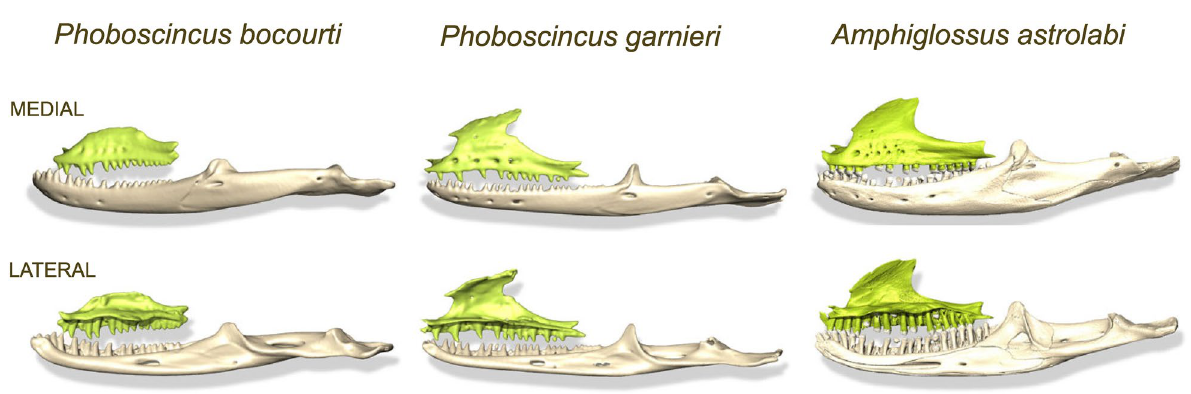
Figure 2. Figure showing different top mandible (in green) and bottom mandible (in white) for Phoboscincus bocourti, P. garnieri and Amphiglossus astrolabi (Beamline An extraordinary example of a rediscovered species is Bocourt´s Terrific Skink Phoboscincus bocourti (Broc- chi, 1876). It was only known from its holotype (supplementary Fig. S1), captured around 1870 in New Caledonia with no further precise locality data, but most likely captured on the largest island called Grande Terre 7 . In 2000, a juvenile was found dead, but not collected, on the beach on an islet off Île des Pins. It was likely prey dropped by a raptor. The first live and immediately correctly identified specimen was found in 2003 by one of us (II) and released. Subsequently one individual was captured and released in 2005, (II), seven other specimens (three captured and released and four more were photographed) in 2012 (by, MH and II), and another individual, illegally collected, in 2018 8 . Of the nearly 100 lizards endemic to New Caledonia and the 19 species native to the Île des Pins (Isle of Pins) (152 km 2 ) 9 , only P. bocourti is restricted to one satellite islet of the Isle of Pins (less than 1 km 2 area). Although this species is most likely present in several other surrounding islets 10 , it is one of the most geographically restricted endemic skink species in the world (Fig. 1). The unusual large size of the holotype [50 cm total length, 28 cm snout-vent length (SVL)] and curved anterior teeth gave rise to the generic common name, the Terrific Skink (AKA the Terror Skink). Intriguingly, such predatory-type dentition is often associated with the smaller insectivorous skinks, as teeth in larger species tend to have a cylindrical shaft with rather blunt conical tips for a diet that is more plant based. The more widespread Giant Skink, Phoboscincus garnieri (Bavay, 1869) (~ 20 cm SVL), the only other species within the genus 11 , has a very different dentition (Fig. 2), with rather blunt teeth compared to P. bocourti. This dentition structure suggests a different feeding ecology. Clues to the diet of P. bocourti , and hence the function of its unusual teeth can be derived from recent isotope analyses on the 2005 and 2012 individuals as well as the holotype, which suggested it fed on smaller skinks 12 . Phoboscincus bocourti ´s unusual dental morphology might have been shaped by island isolation, habitat use, and trophic niche (changes in food availability possibly due to seasonal variations). Insularity affects many